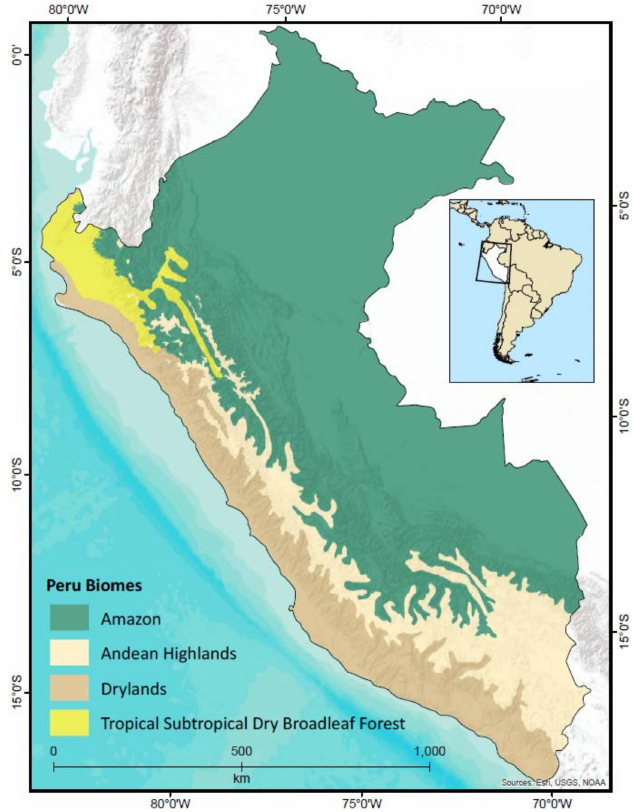
Figure 1. Peru and its four biomes. Inset map shows the location of Peru in South